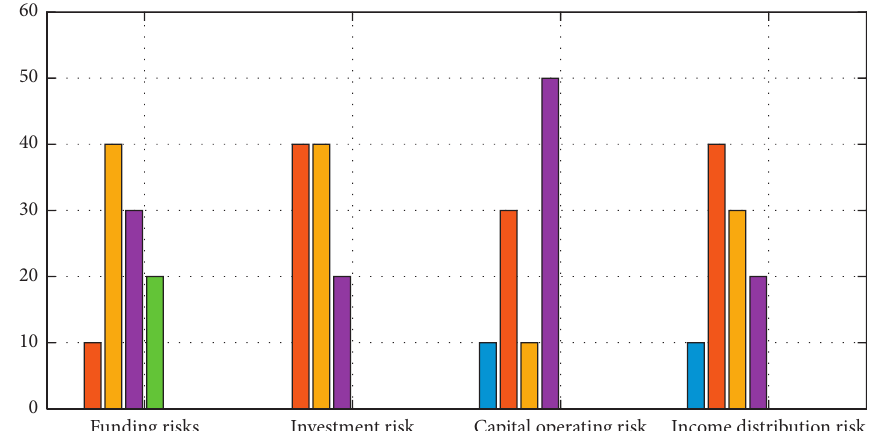
Figure 3: Histogram of the results of the first indicator tier scores.